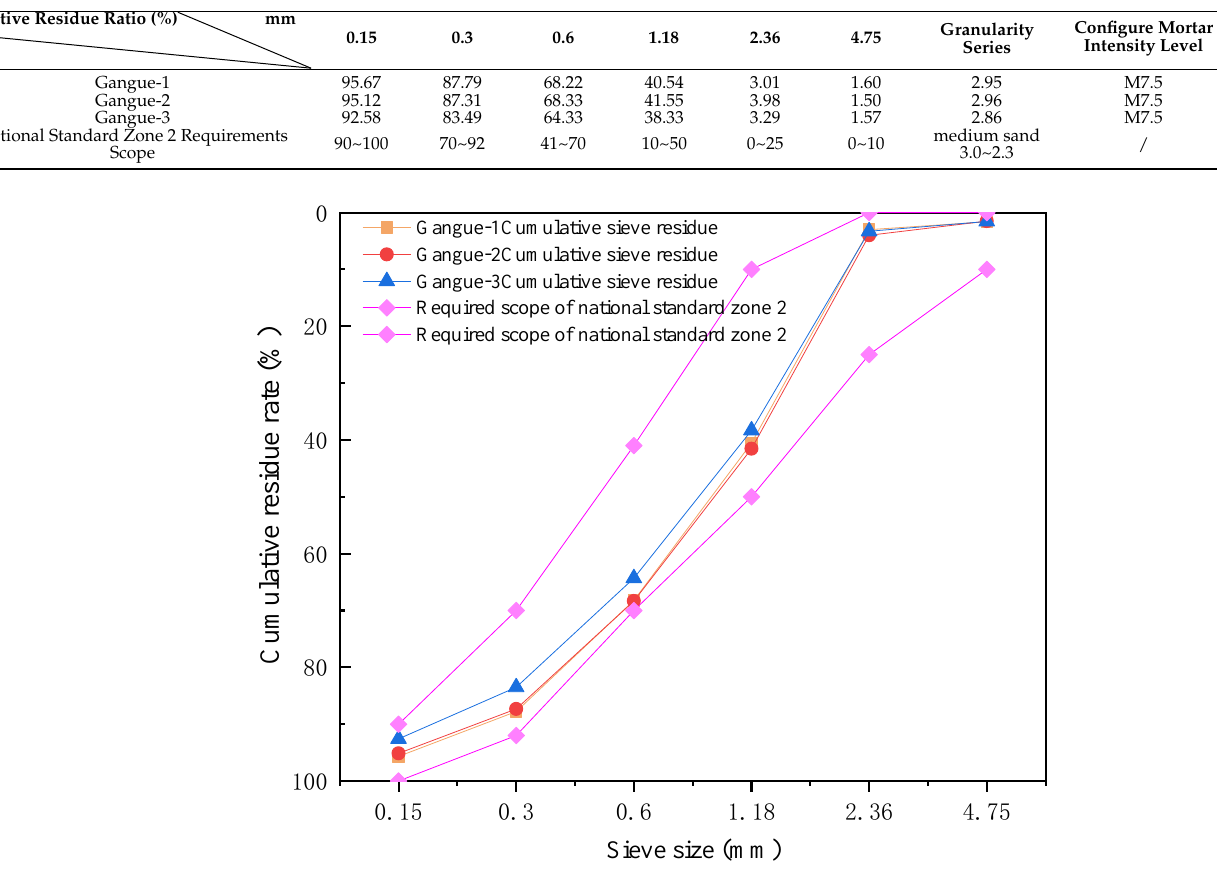
Table 7. The screen residue rate of benchmark sand.